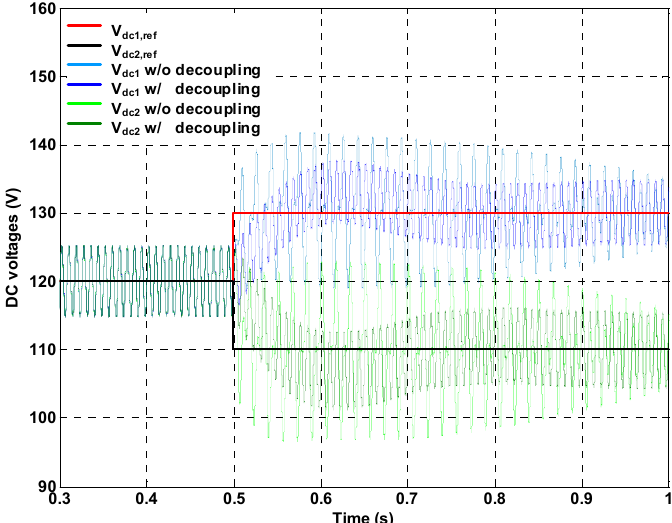
Figure 12. Simulation result of the individual voltage control with respect to the step changes of the DC-input reference with (w/) and without (w/o) inverted decoupling control method.